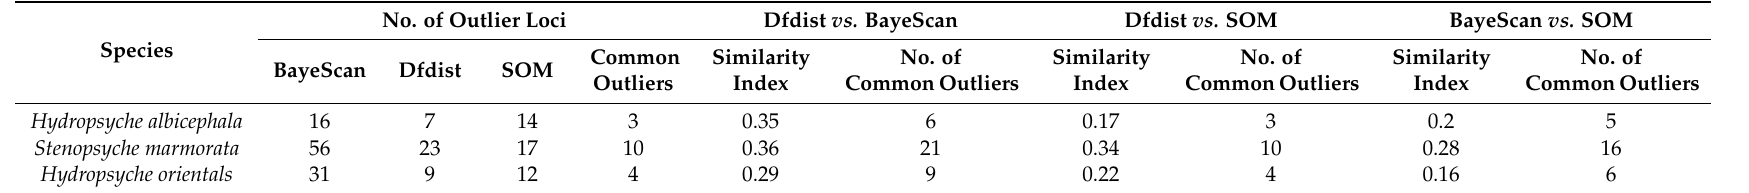
Table 2. Similarity indices and number of common outliers between Dfdist, BayeScan, and